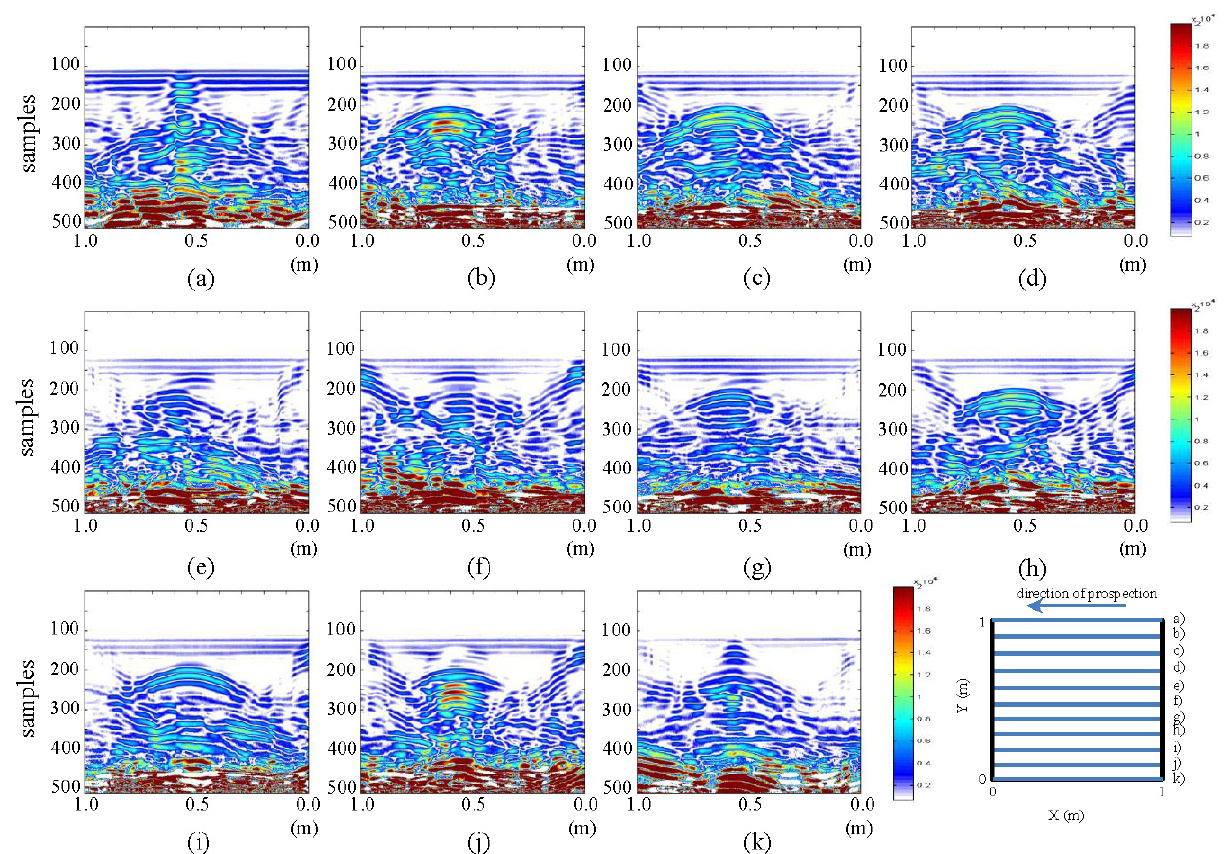
Figure 7. Horizontal profiles: contrasting raw images for initial and final states. ( a – k ) are profiles s1 to s11,